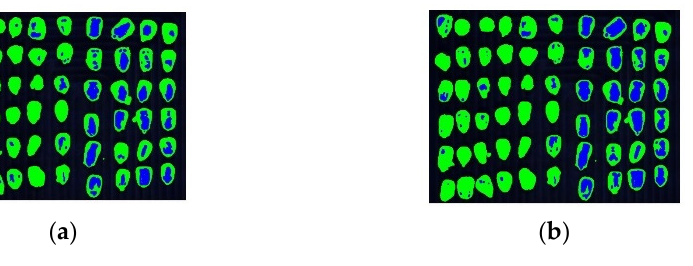
Figure 12. Classification results of SVM and LDA in corn kernel mildew hyperspectral image data